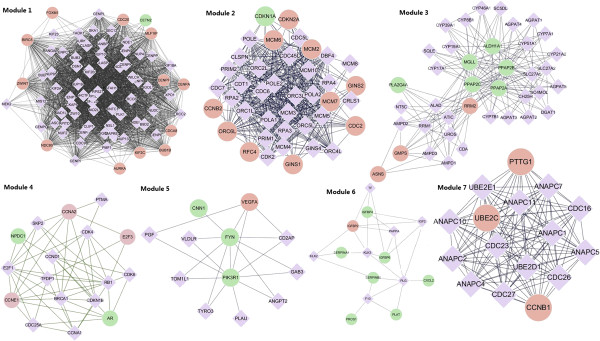
Functional modules mined in the gene-gene interaction network. The purple rhombuses are the LINKERs having the significant interactions (p < 0.05) with differentially expressed genes (DEGs), green circle are the down-regulated DEGs, and red circles are the up-regulate DEGs.